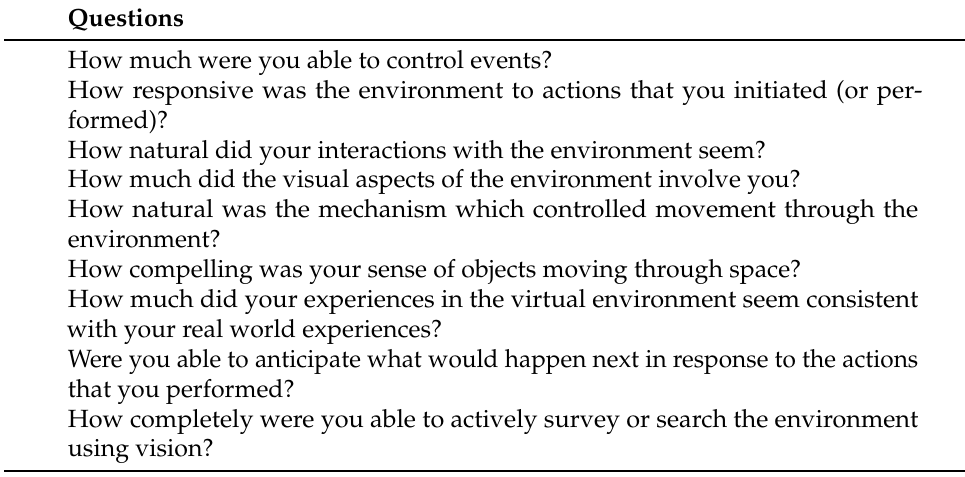
Table A1. Questions of Witmer and Singer 24-question Presence